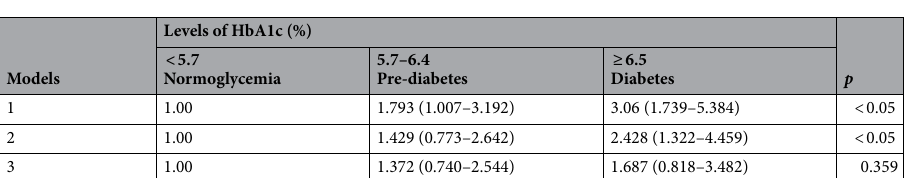
Table 3. Association of the probability of low-grade albuminuria (LGA) with the levels of HbA1c. ORs (95% CI). Model 1: Not adjusted. Model 2: Adjusted for age, sex, alcohol consumption, TC, HDL-c, TG, BMI and WC. Model 3: Adjusted for FPG in addition to the variables in model 2. BMI, body mass index; FPG, fasting plasma glucose; HbA1c, glycated hemoglobin A1c; HDL-c, high density lipoprotein cholesterol; TG, triglyceride; WC, waist